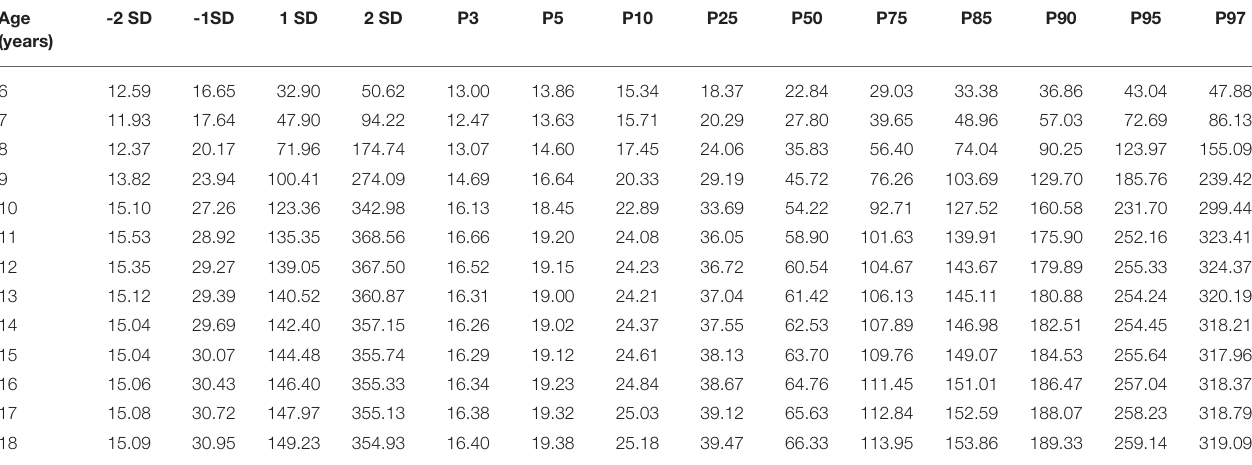
TABLE 1 | SAT-for-age (cm 2 ) references for boys.